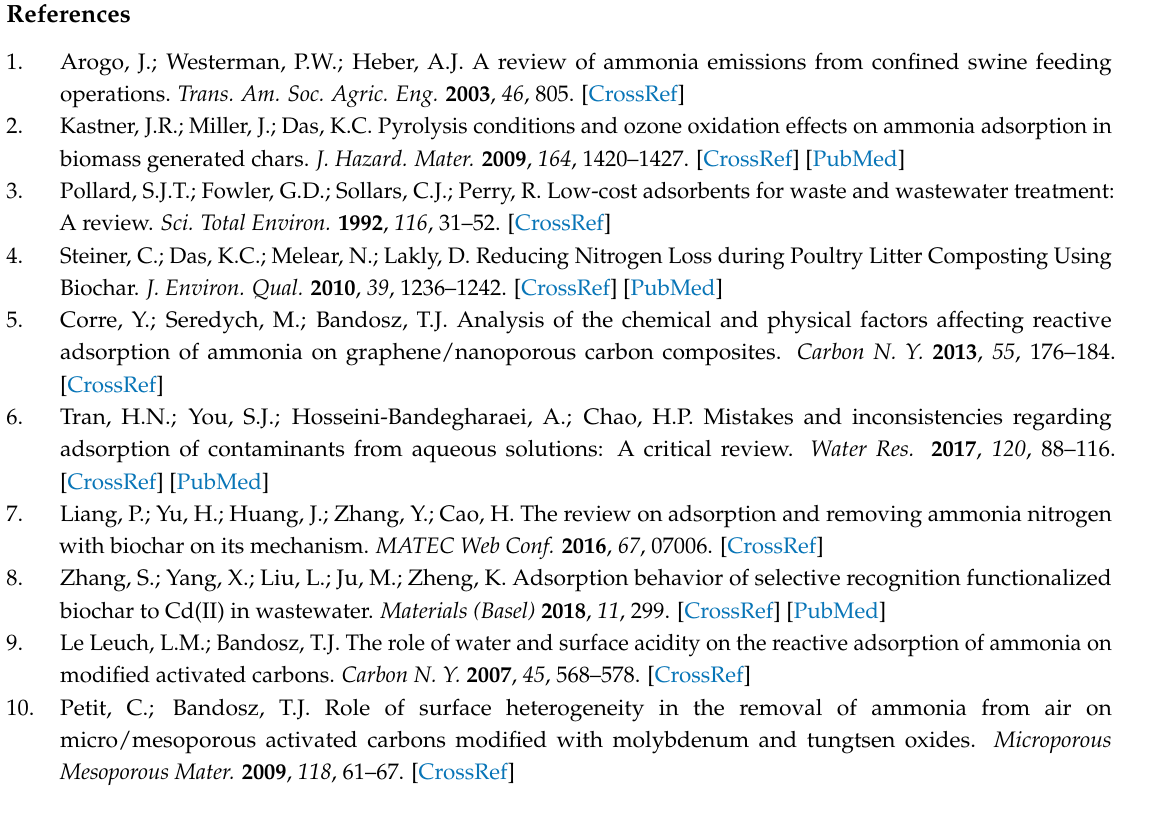
Figure S1. FTIR spectra of treated and untreated ( a ) OAK 250 ( b ) OAK 450, and ( c ) OAK 650 chars